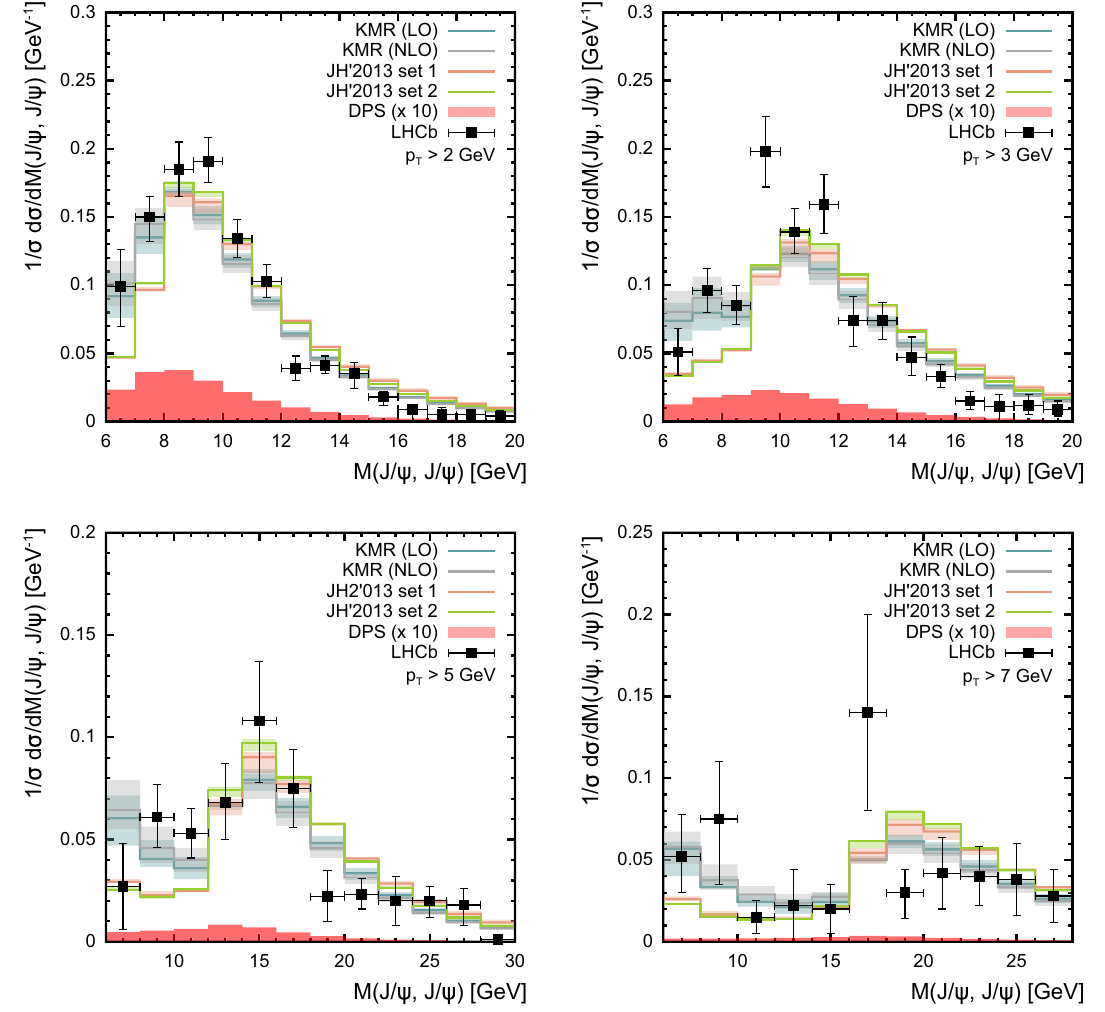
√ s = 8 TeV as a function of the invariant mass of the